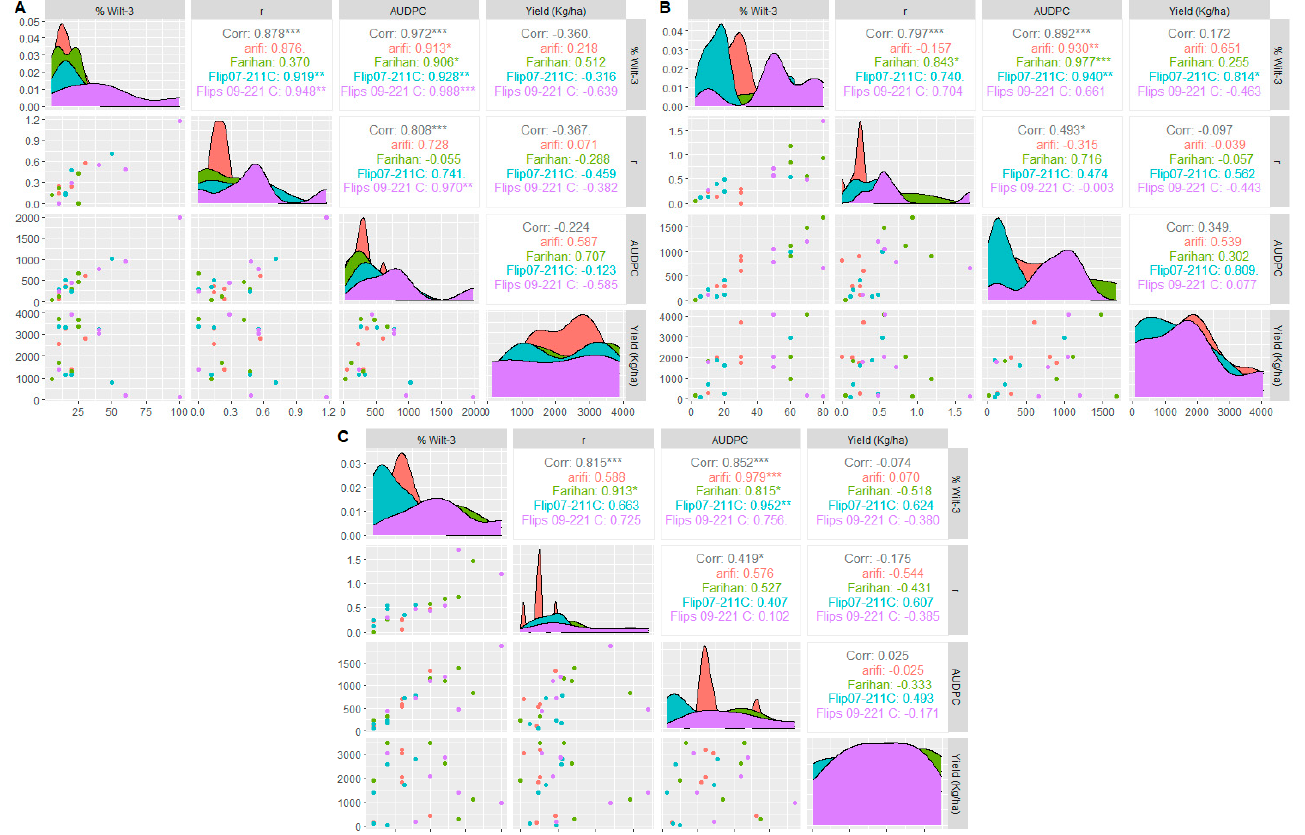
Figure 4. Correlogram showing the correlation between disease parameters and seed yield in the three sowing dates ( A ) mid-December, ( B ) mid-January, and ( C ) mid-February. Significance code: “***”0; “**” 0.001; “*” 0.01; “.” 0.05.